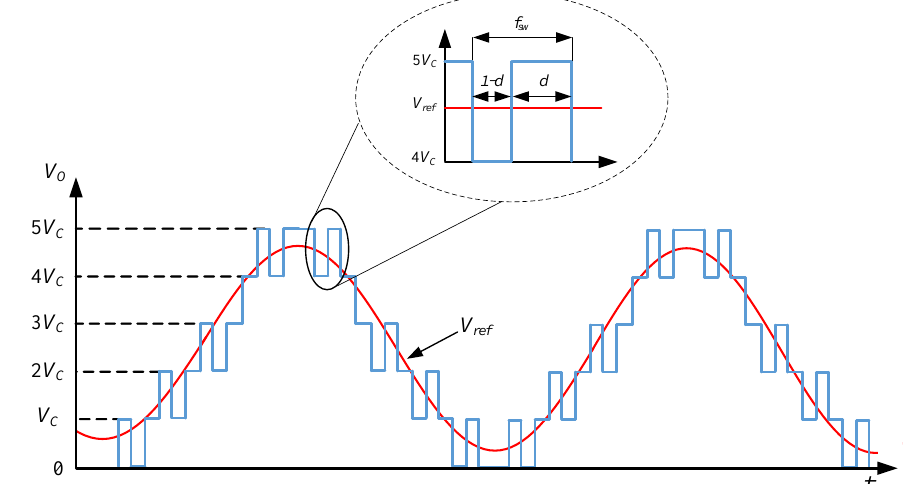
Figure 6. NLM arm waveform ( n = 10).